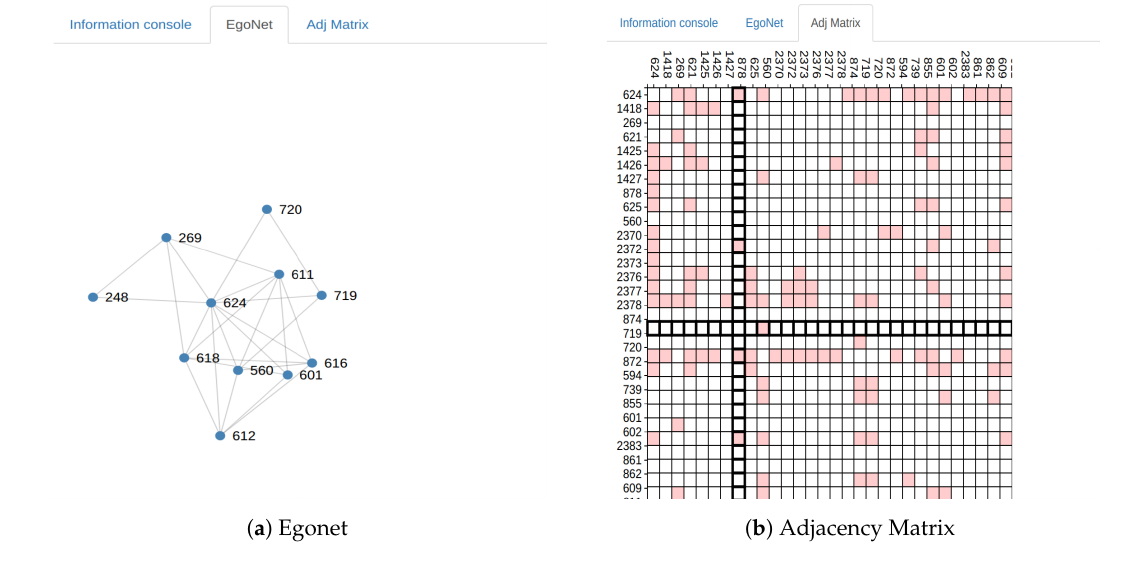
Figure 7. Node-specific summarization: representation of the egonet and adjacency matrix of a selected node.